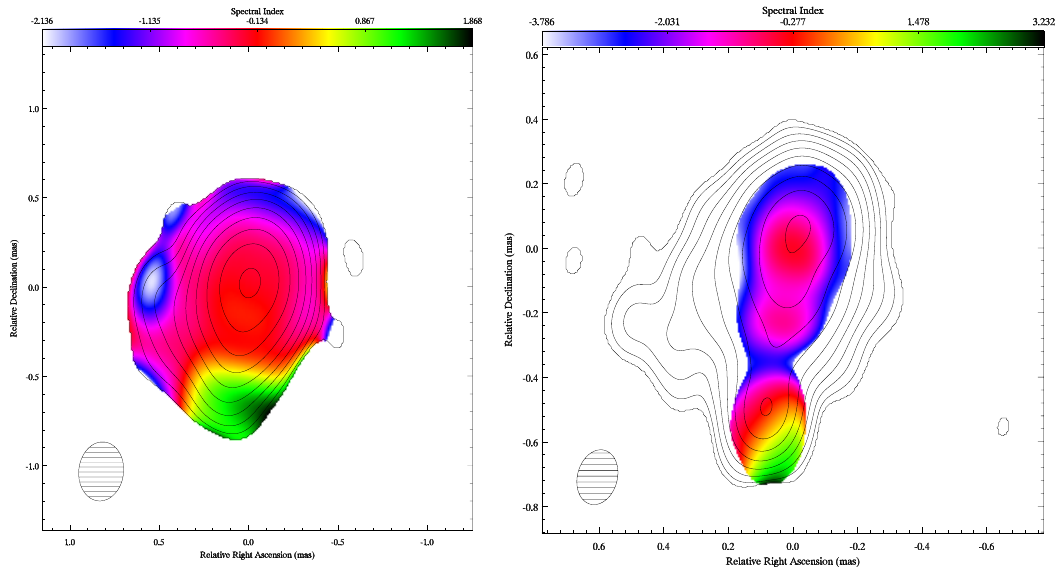
Figure 6. Left : The 22 GHz to 43 GHz spectral index distributions overlaid with 22 GHz total intensity contours. Images at the two observing frequencies were convolved with a restoring beam with FWHM 0.33 × 0.25 mas and PA = − 6.40 ◦ ; Right : 43 GHz to 86 GHz spectral index distributions overlaid with 43 GHz total intensity contours. Images at the two observing frequencies were convolved with a restoring beam with FWHM 0.17 × 0.123 mas and PA = − 14.85 ◦